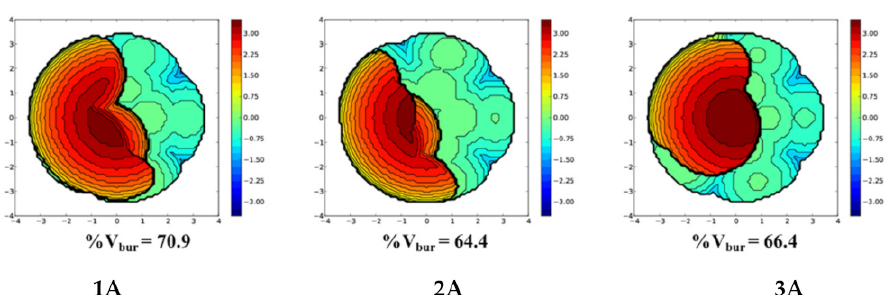
Figure 5. Topographic steric maps and the buried volume %V Bur of three active species 1A , 2A , and 3A . The maps were obtained starting from the minimum energy structures of complexes optimized by DFT calculations.